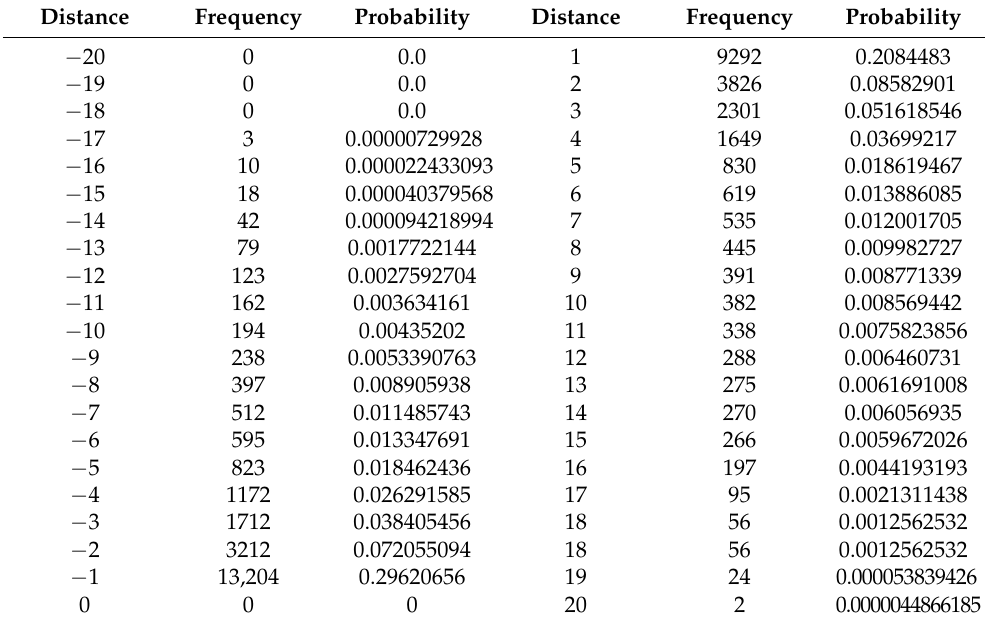
Table 3. Acquisition noise distribution table in binary images.